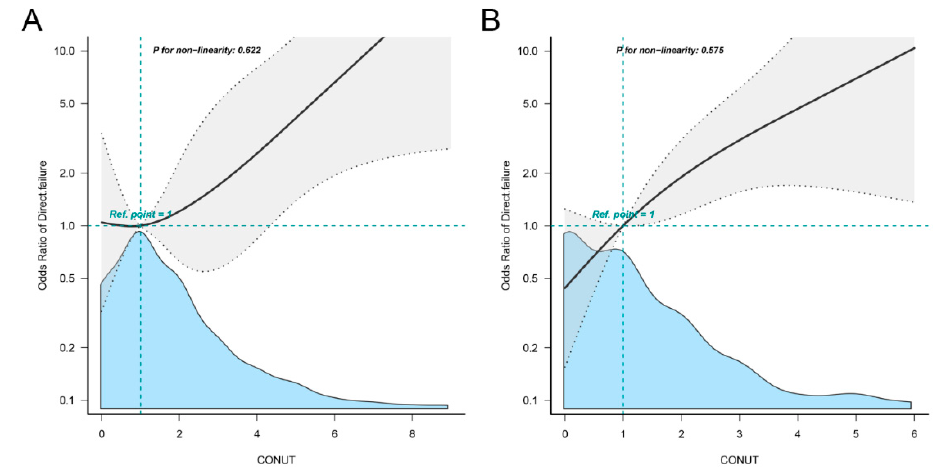
Figure 3. Restricted cubic spline models representing the associations of CONUT score and treatment failure directly related to PJI at 1st ( A ) or 2nd stage ( B ) exchange. Adjusted for baseline characteristics such as age, gender, Body Mass Index, pathogens, number of previous surgeries, knee or hip joints, primary diagnosis, smoking, and comorbidities. Reference group is that the value of CONUT score is 1. The gray area represents the confidence interval of the model. The blue area is the density plot of the CONUT scores. CONUT, Controlling Nutritional